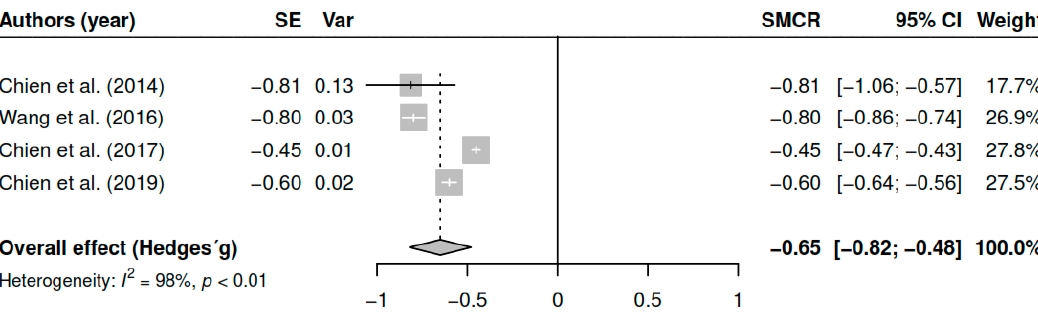
Table 1. Analysis of moderating variables (meta-regression).